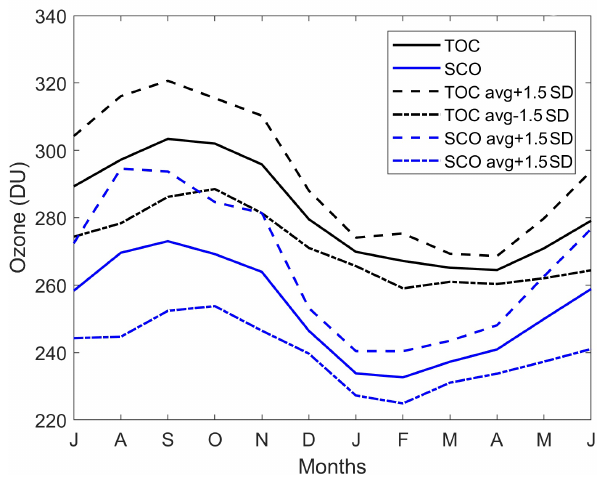
Figure 3. Monthly means ± 1 . 5SD for total ozone column and stratospheric column ozone starting in July and ending in June.